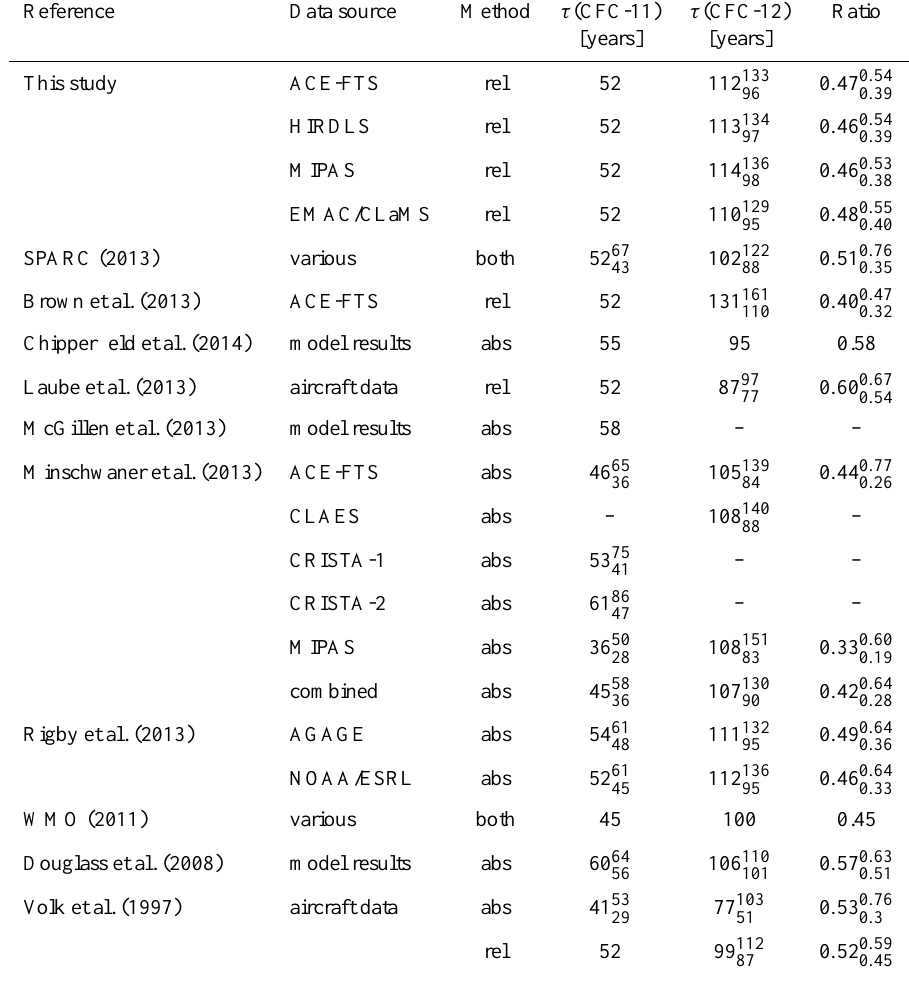
Table 2. Comparison of stratospheric lifetime estimates of CFC-11 and CFC-12 from different studies. The table lists the data sources of the studies and if absolute (abs) or relative (rel) lifetime estimates are provided. All relative lifetime estimates are normalized to a CFC- 11 lifetime of 52 years. A sub- and superscript notation is used to report errors. Note that error definitions vary between the studies (see individual references). In particular, for SPARC (2013) the errors represent 2 σ